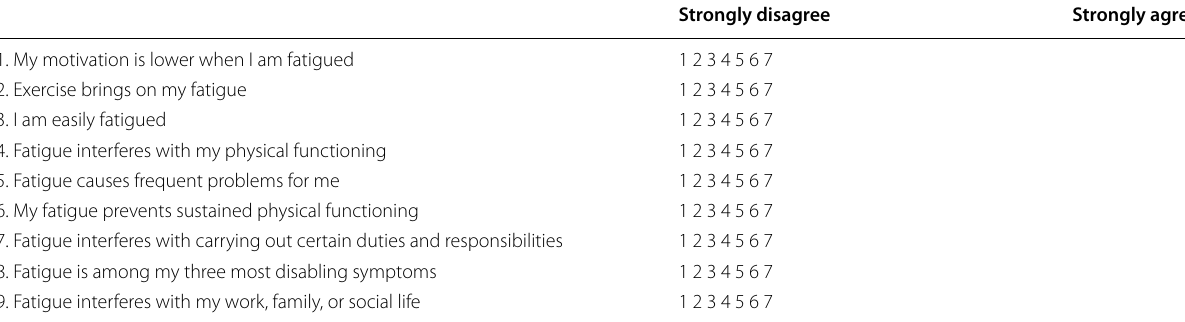
Table 1 Fatigue severity scale (FSS) (Krupp et al. 1989) [9]